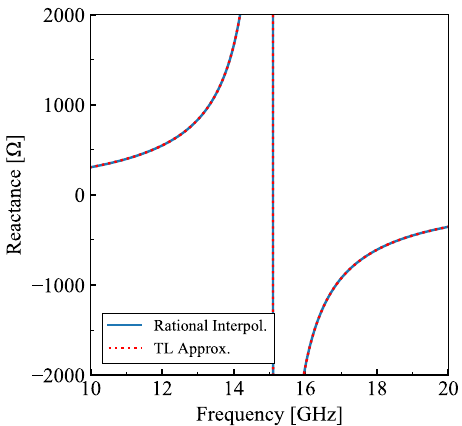
Fig. 3. Rational function interpolation of surface reactance.